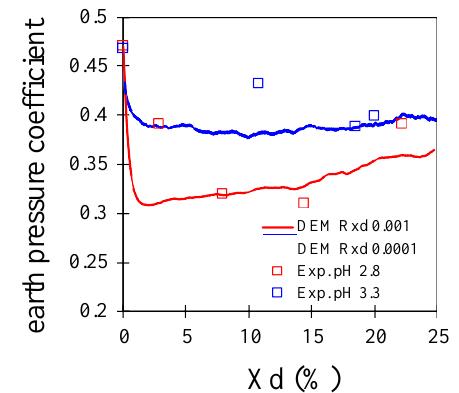
Fig. 7 . Validation of EPC against concurrent chemo- mechanical loading response from the experiment.